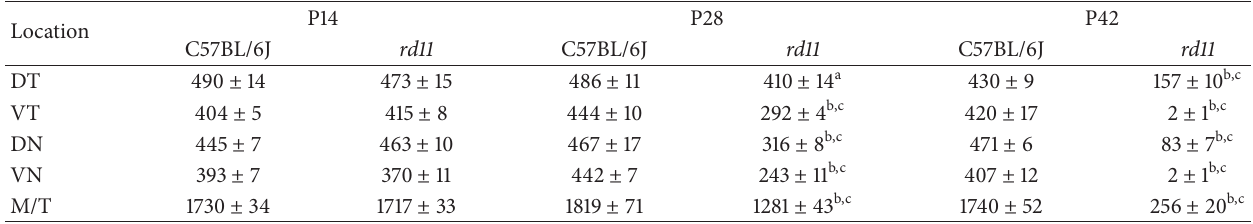
Table 2: Comparison of L-opsin density in retinal whole mounts of C57BL/6J control and rd11